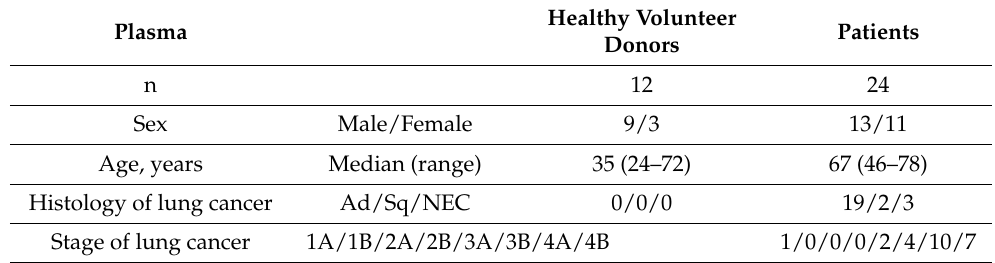
Table 1. Disease